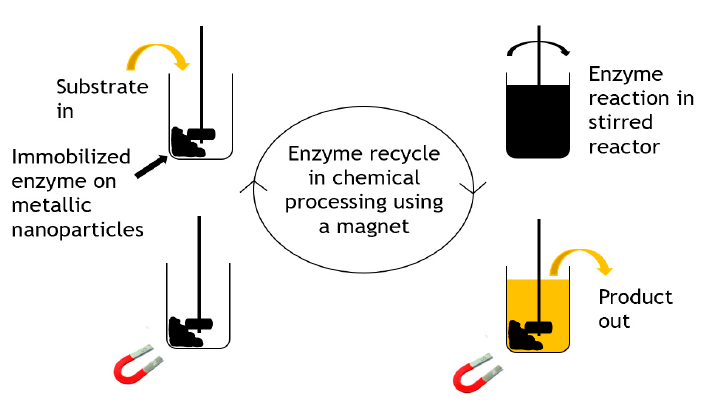
Figure 5. Recycling strategy for immobilized magnetic enzymes.